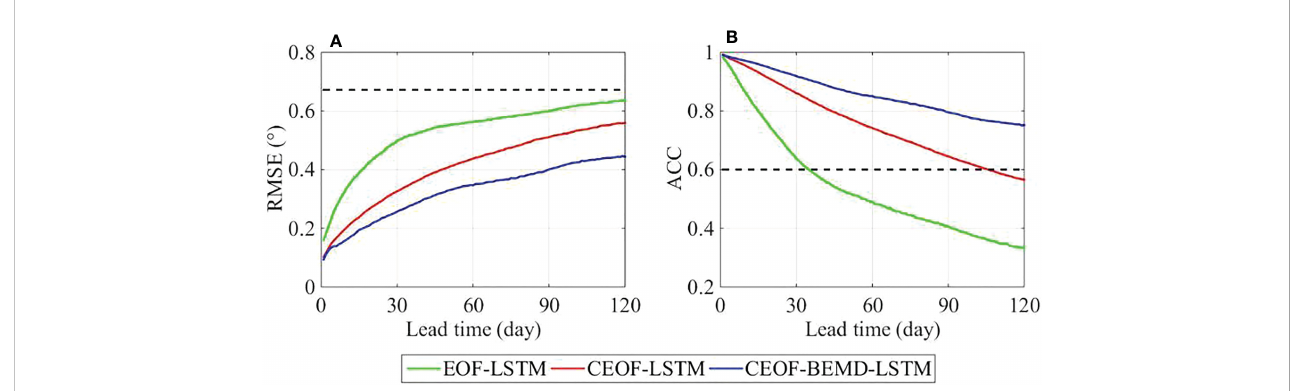
FIGURE 3 (A) Space-averaged RMSE (°) of the prediction using the EOF-LSTM, CEOF-LSTM, and CEOF-BEMD-LSTM models. The dashed black line indicates the climatological standard deviation of the Kuroshio path. (B) Averaged ACC values of the predictions using the EOF-LSTM, CEOF-LSTM, and CEOF-BEMD- LSTM models. The dashed black line indicates spatial ACC of 0.6, a thumb rule for measuring “ usefulness ” of